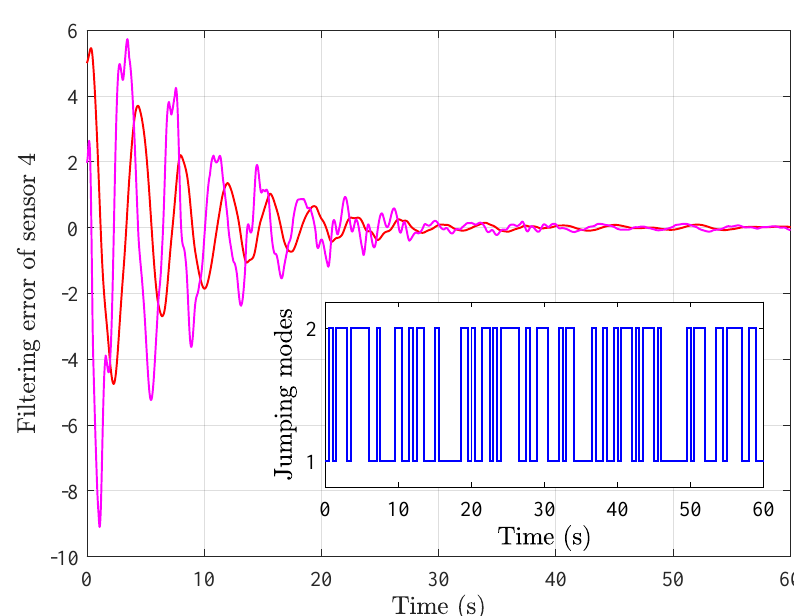
Figure 5. Filtering errors of sensor 3.